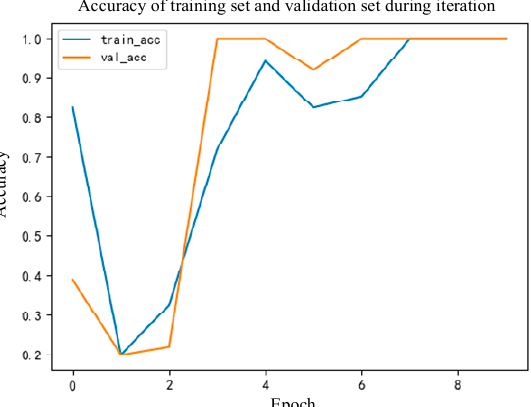
Figure 8. Iteration diagram of the accuracy of the algorithm proposed in this paper in the case of dataset 3.